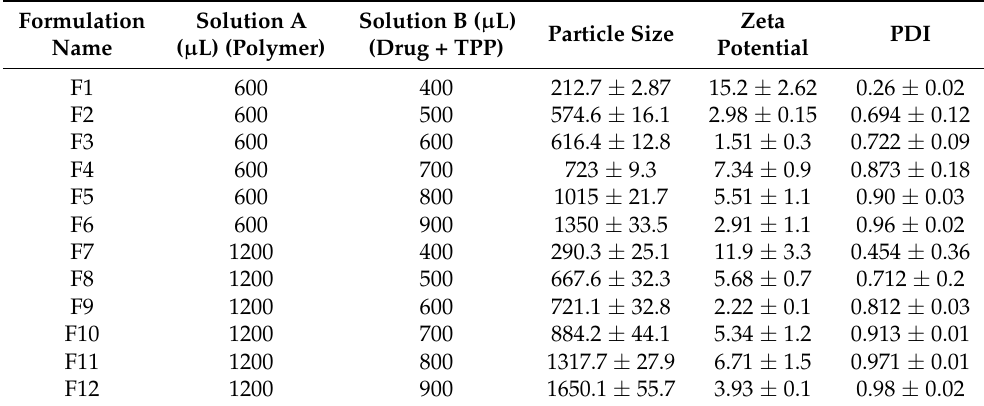
Table 2. Effect of polymer and TPP concentration on particle size, zeta potential, and PDI. Formulation